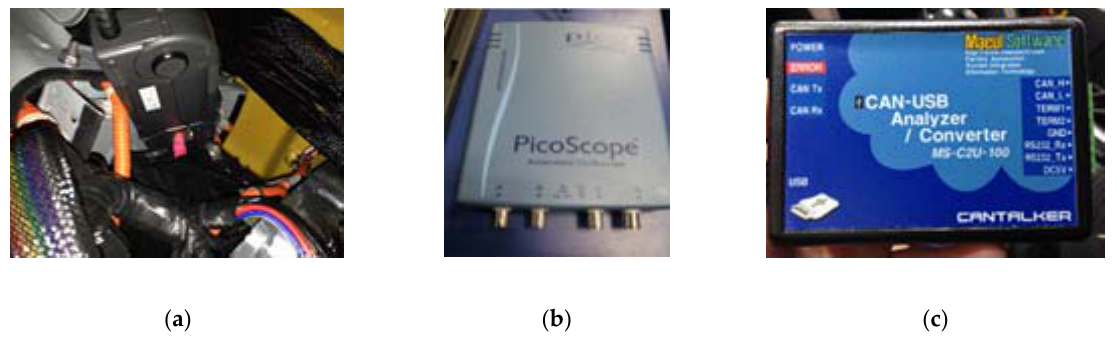
Figure 3. Data acquisition devices: ( a ) Ammeter clamp; ( b ) PicoScope; ( c ) Cantalker.